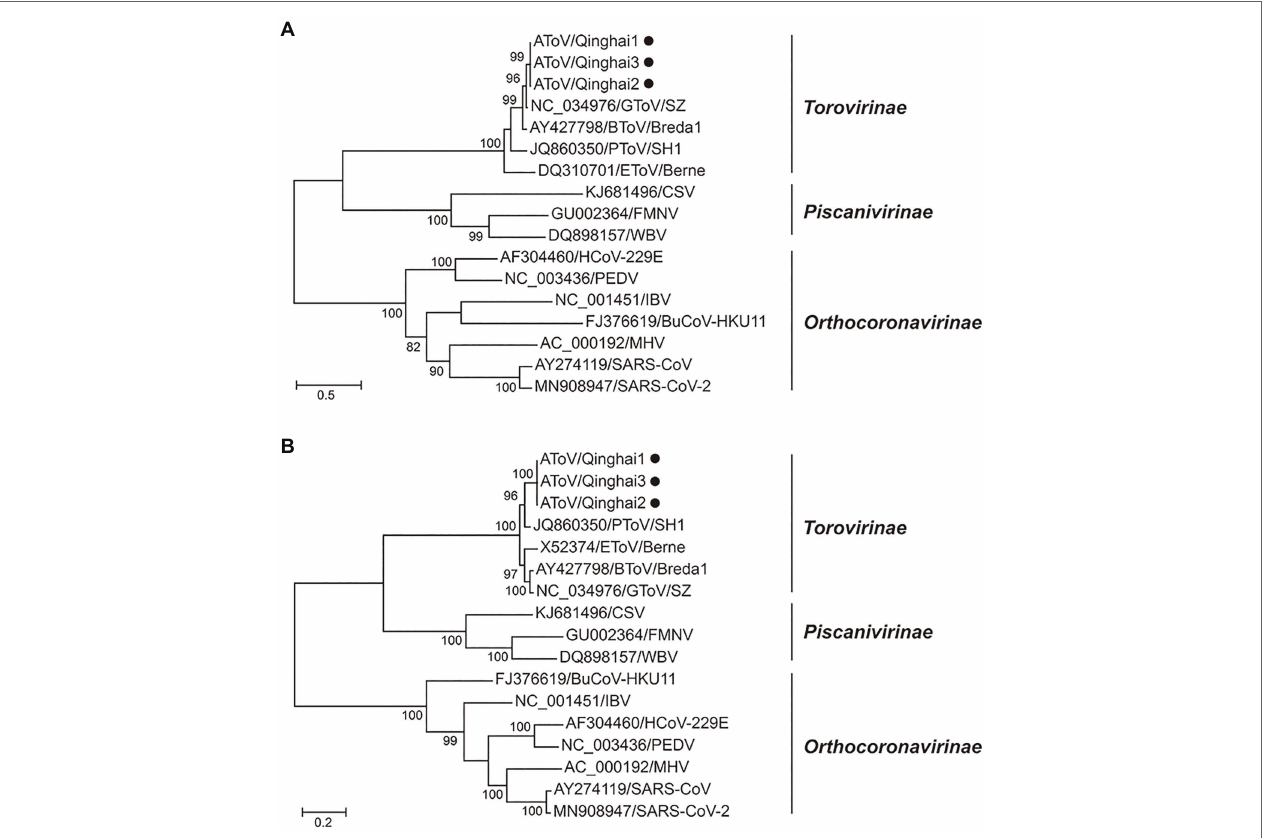
FIGURE 4 | Phylogenetic relationship of toroviruses, piscaniviruses, and coronaviruses within the order Nidovirales. (A) The phylogenetic tree of ORF1a; (B) The phylogenetic tree of ORF1b. Strains of AToV were marked with black circles. Phylogenetic trees were constructed using MEGA 7.0 by the maximum likelihood method (1,000 bootstrap replications). Bootstrap values (>70%) are shown at the branches. Scale bars below indicate the amino acid substitutions per